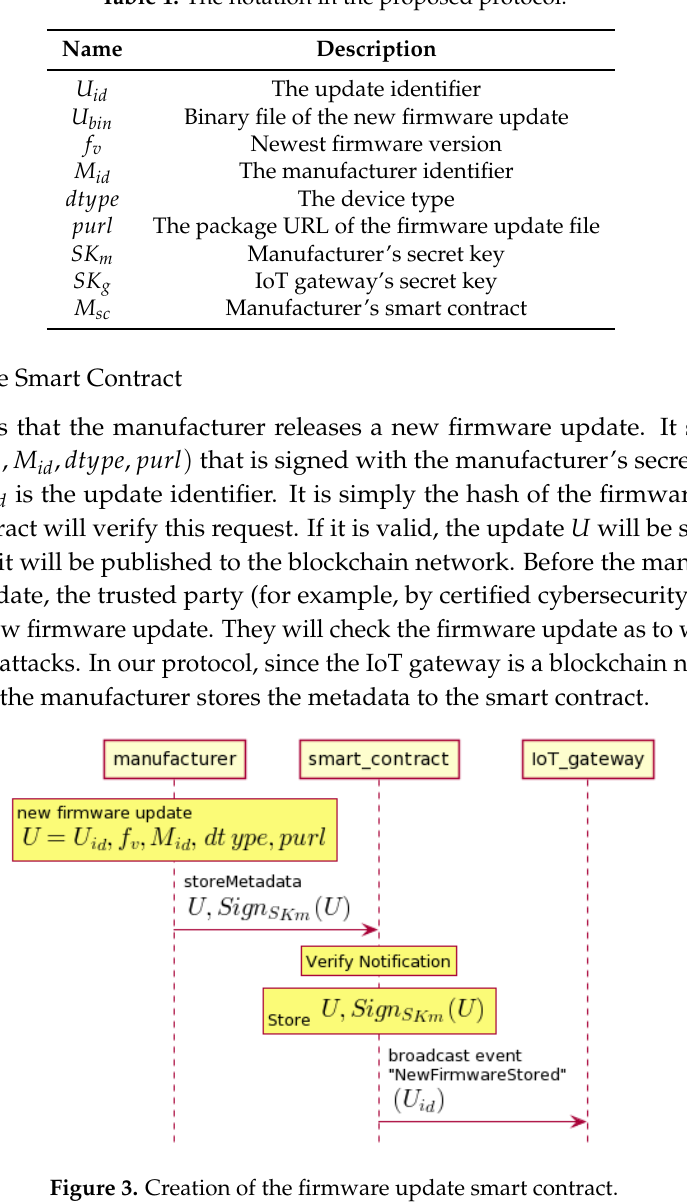
Table 1. The notation in the proposed protocol.